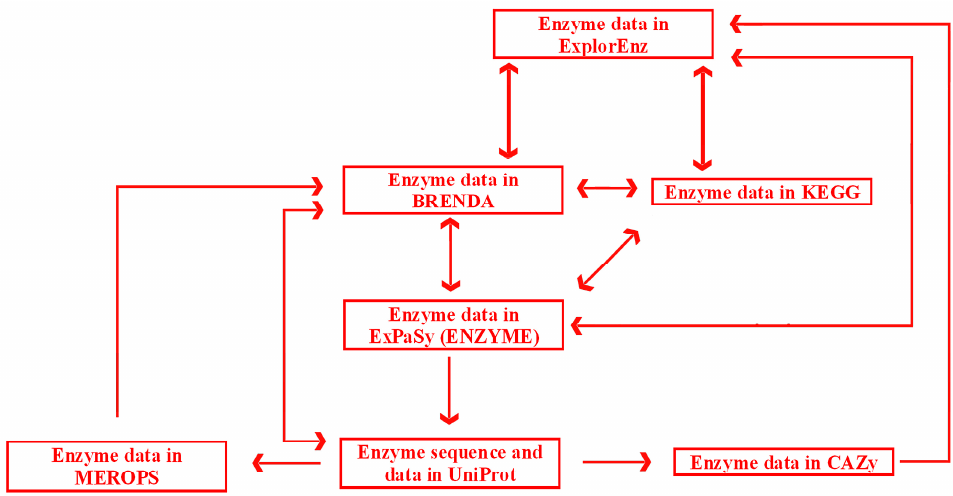
Figure 6. Diagram of links between enzyme data in exemplary databases. Arrows indicate possible directions of search. The color coding scheme is the same as in Figure 5.